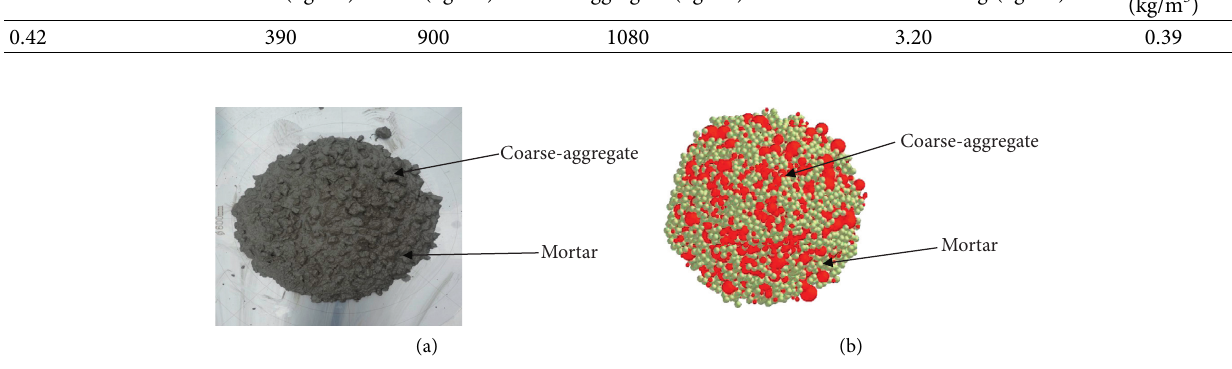
Table 1: The mix proportions of the fresh concrete.